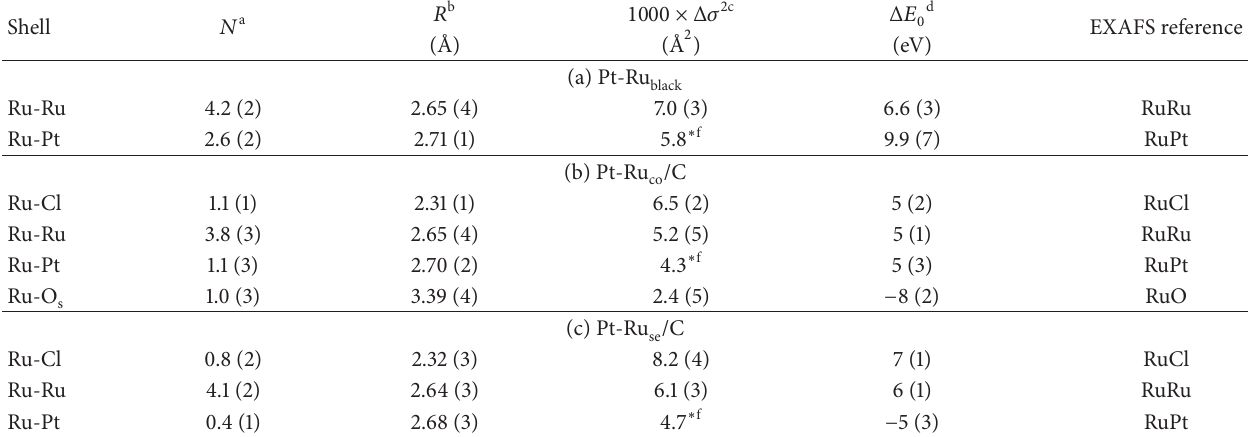
Table 2: Summary of EXAFS analysis results for Pt-Ru catalysts at Ru edge.